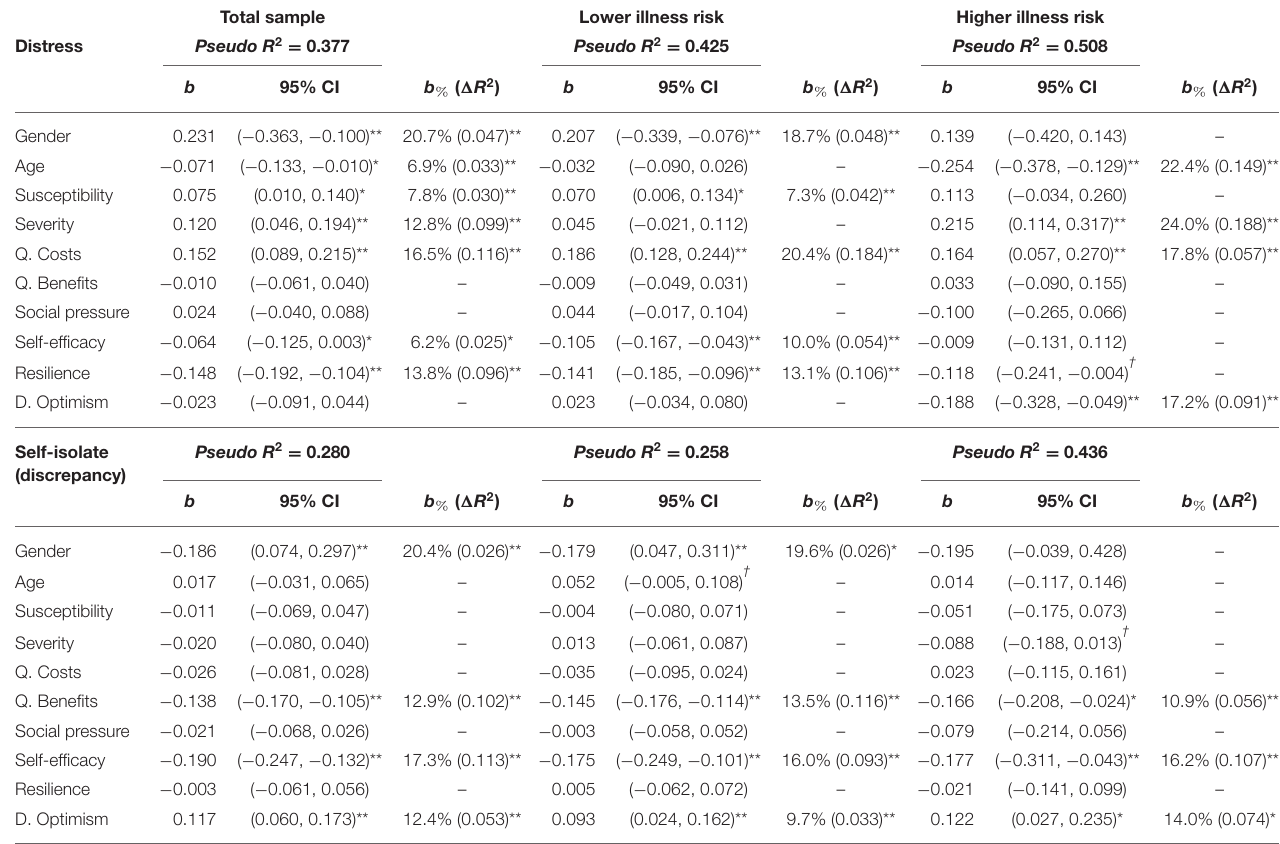
TABLE 5 | Multiple regression analyses predicting distress and discrepancy to